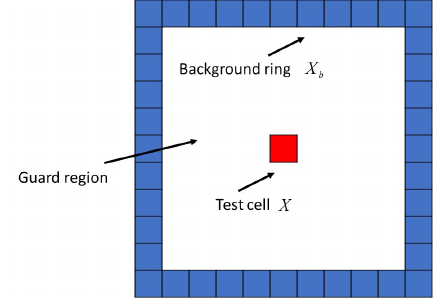
Figure 9. The illustration of CFAR